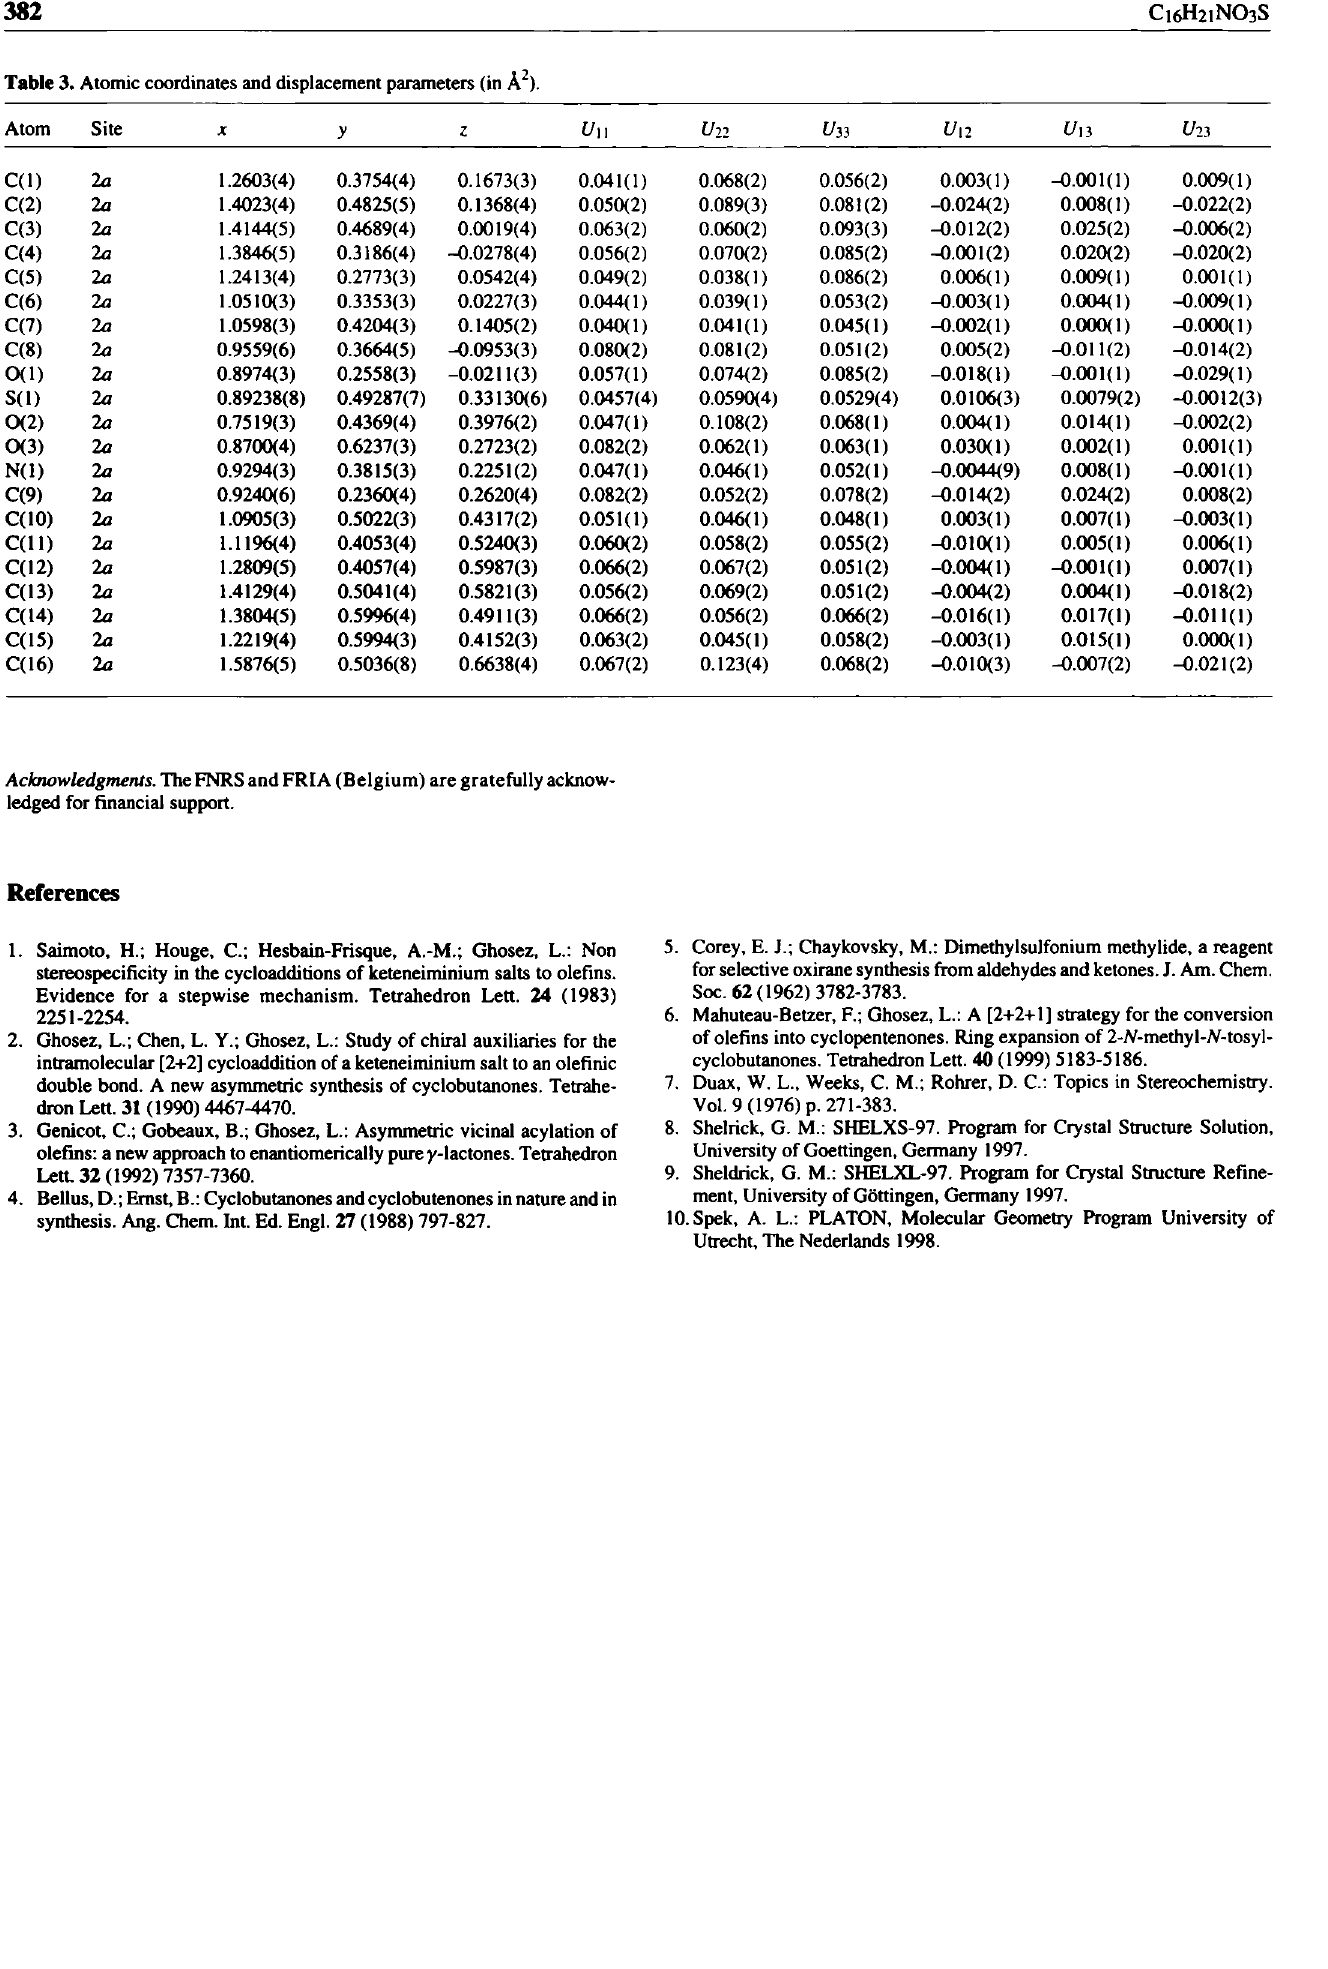
Table 3. Atomic coordinates and displacement parameters (in Â 2